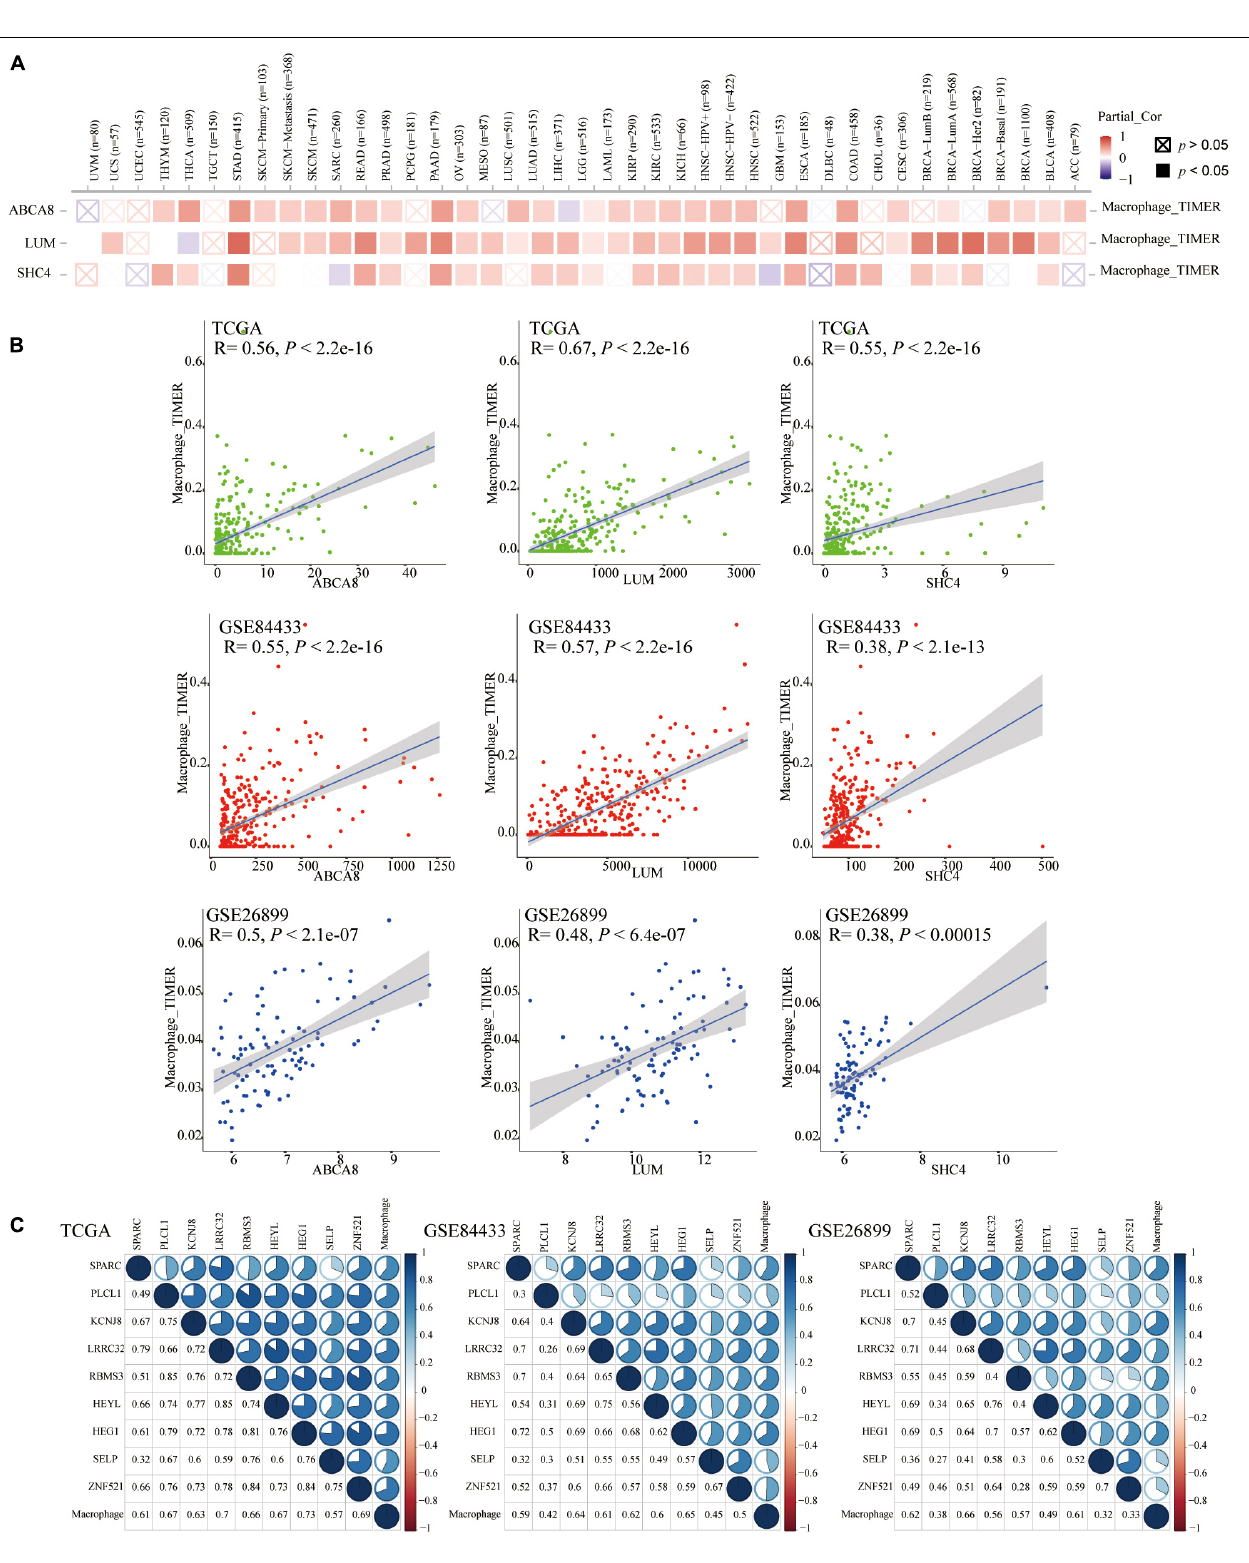
FIGURE 6 | Spearman correlation analysis between 3 key genes and the macrophage abundance. (A) In pan-cancer on the Timer2.0, Especially in STAD, 3 key genes were significantly correlated with the abundance of macrophages. (B) In TCGA and GEO data sets, 3 key genes were also significantly associated with macrophage abundance. (C) The Spearman correlation between the other 9 genes and macrophage abundances.